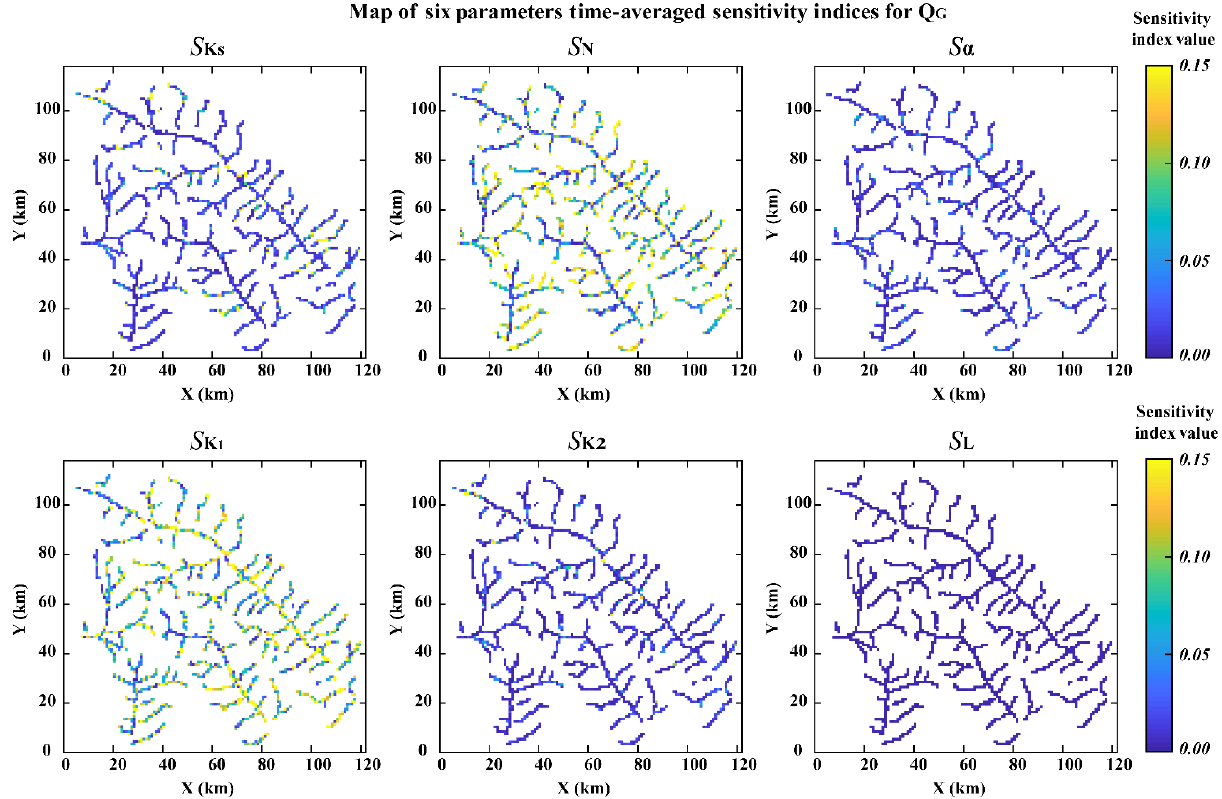
Figure C1. Maps of six parameter sensitivity indices for groundwater contribution to stream flow ( Q G )